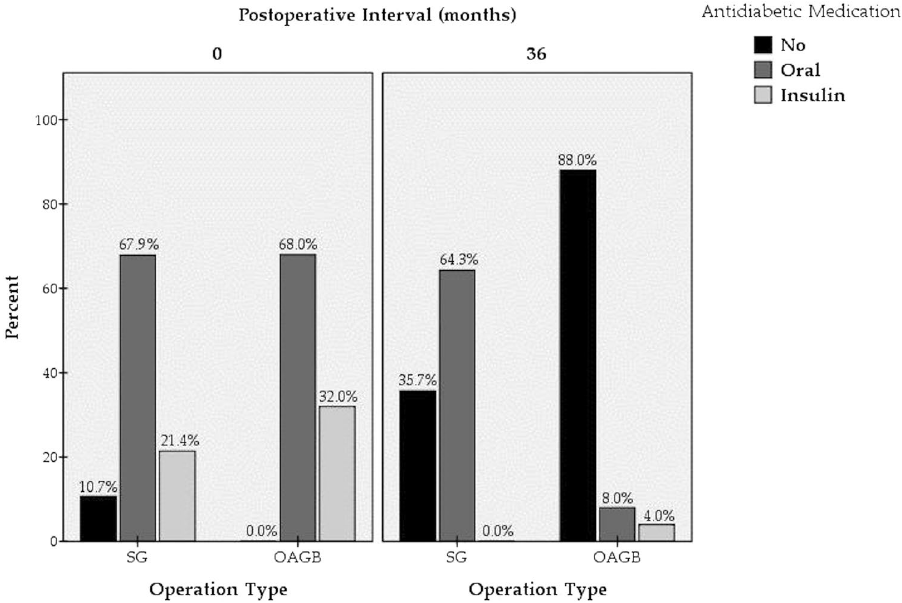
Figure 2. Antidiabetic medication required for DM control for both patient subgroups at the time of operation and 36 months